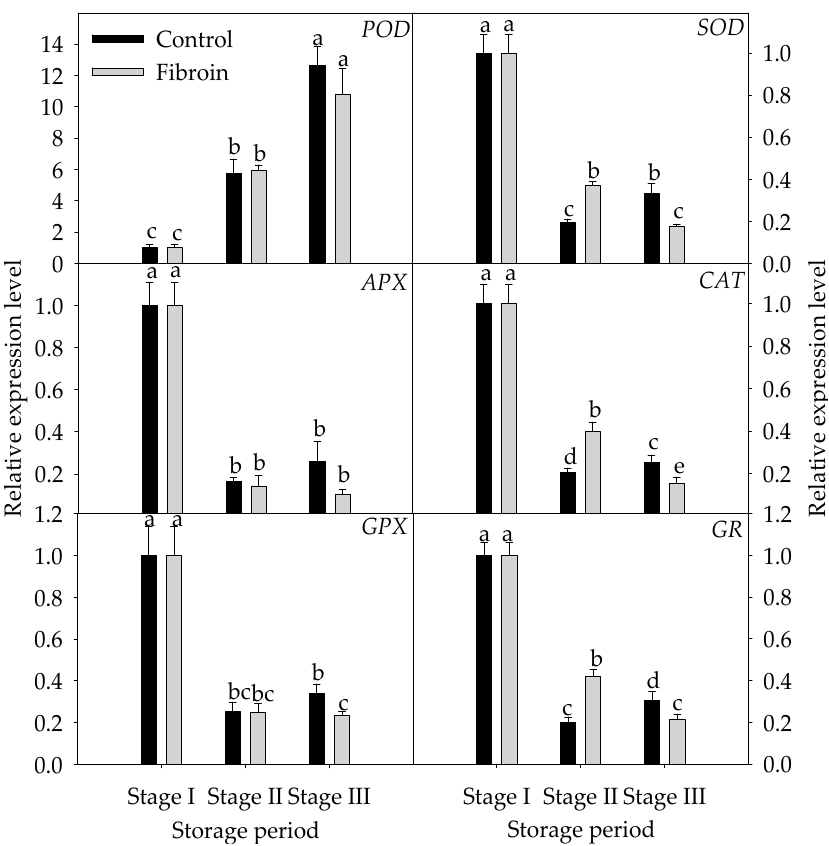
Figure 5. Relative gene expression levels of POD , SOD , APX, CAT, GPX, and GR in peels of harvested banana fruit during cold storage. The data are presented as means ± standard errors (n = 3). The means with different letters are significantly different ( p < 0.05).